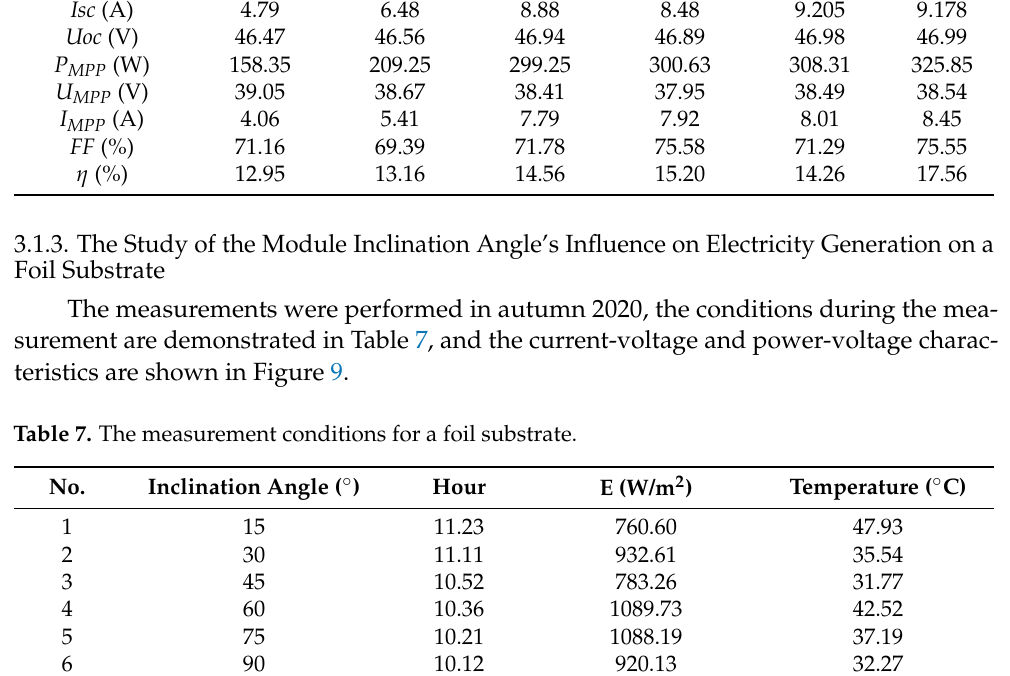
Table 6. Results of measurements and calculations for a white substrate.